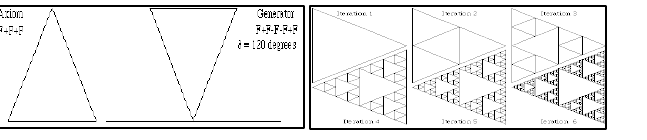
Figure 5: Lindenmayer system axiom